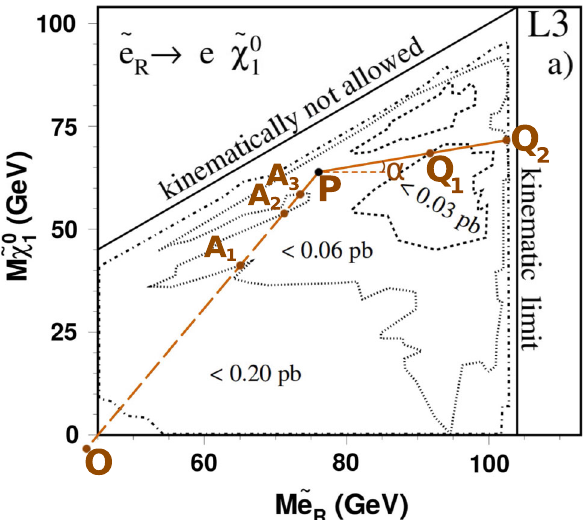
Fig. 6 Example of the limit interpolation process, based upon Fig. 2a of Ref. [6]. The line segment OP is used to find the intersection points A 1 ,A 2 ,andA 3 ,whichdeterminethatP iswithinthe0.06pblimit.Then, foreachangle α ∈ [ 0 , 2 π ] ,thelinesegmentsPQ 1 andPQ 2 contributeto the weighted average limit at the point P. More details of this procedure are described in the main body of